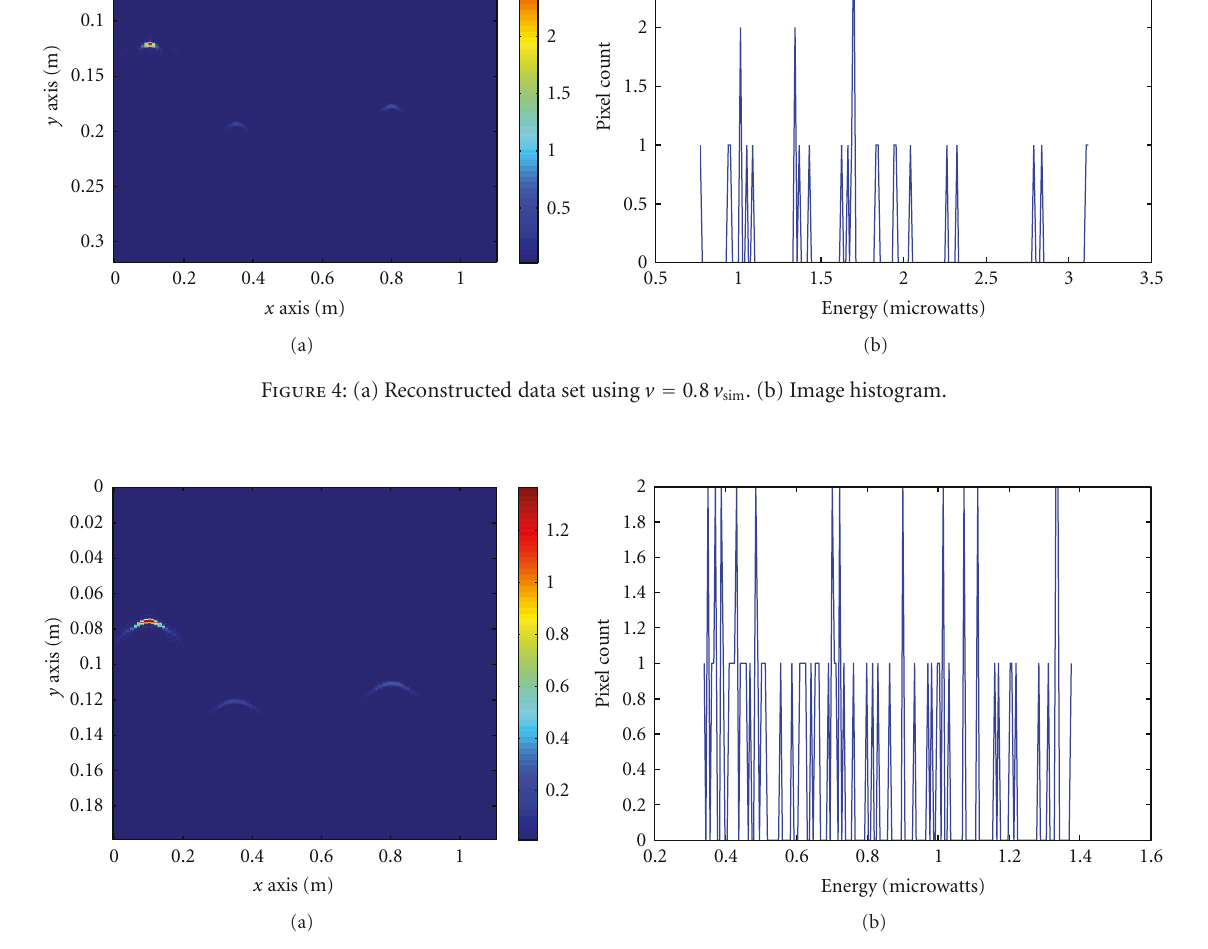
Figure 5: (a) Reconstructed data set using v = 0 . 5 v sim . (b) Image histogram.